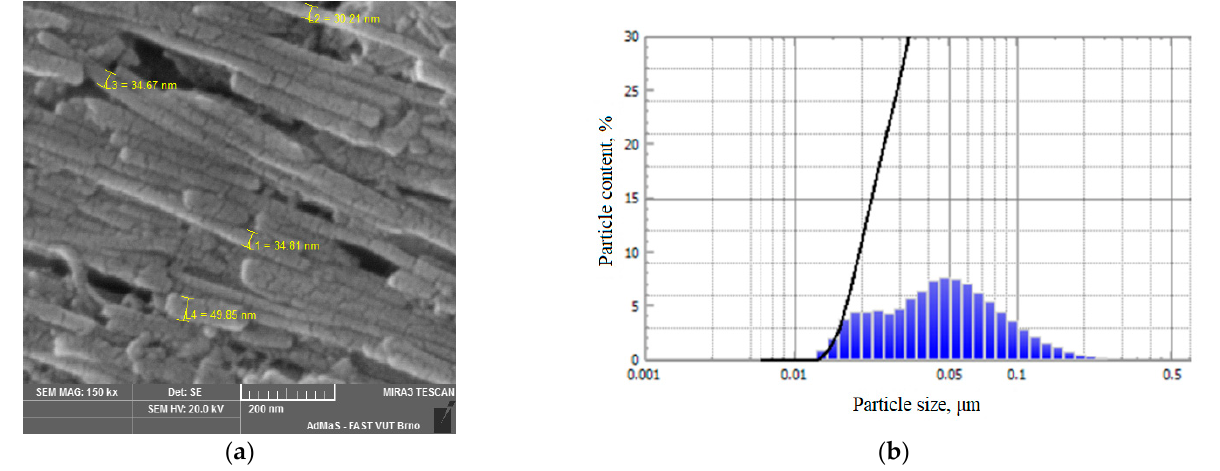
Figure 1. Suspension of chrysotile fibers: ( a ) microstructure of chrysotile fibers at 20,000-fold magnification; ( b ) distribution of chrysotile particles after processing in the cavitation disperser.